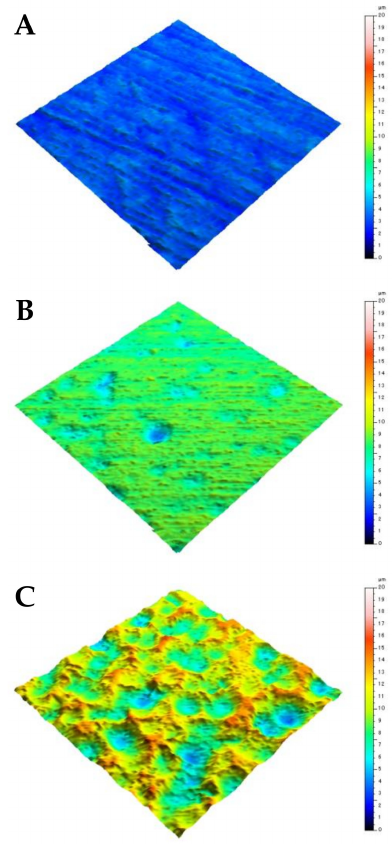
Figure 3. Three-dimensional images of specimen surfaces. ( A ) Ti. ( B ) CTO 700. ( C ) CTO 800. Table 1. Surface roughness of specimens measured by a three-dimensional non-contact surface roughness tester. Results are mean ± standard deviation. * p < 0.05, v. Ti and CTO 800. † p < 0.05, v. CTO 700 and CTO